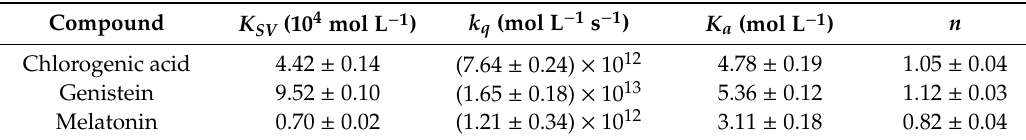
Table 2. Experimentally determined quenching and binding parameters for BSA–phytochemical complexes obtained at equal conditions of pH (7.4) and temperature (37 ◦ C / 310 K), including the Stern − Volmer quenching constant ( K SV ), bimolecular quenching constant ( k q ), binding constant ( K a ), and the number of binding sites ( n ).